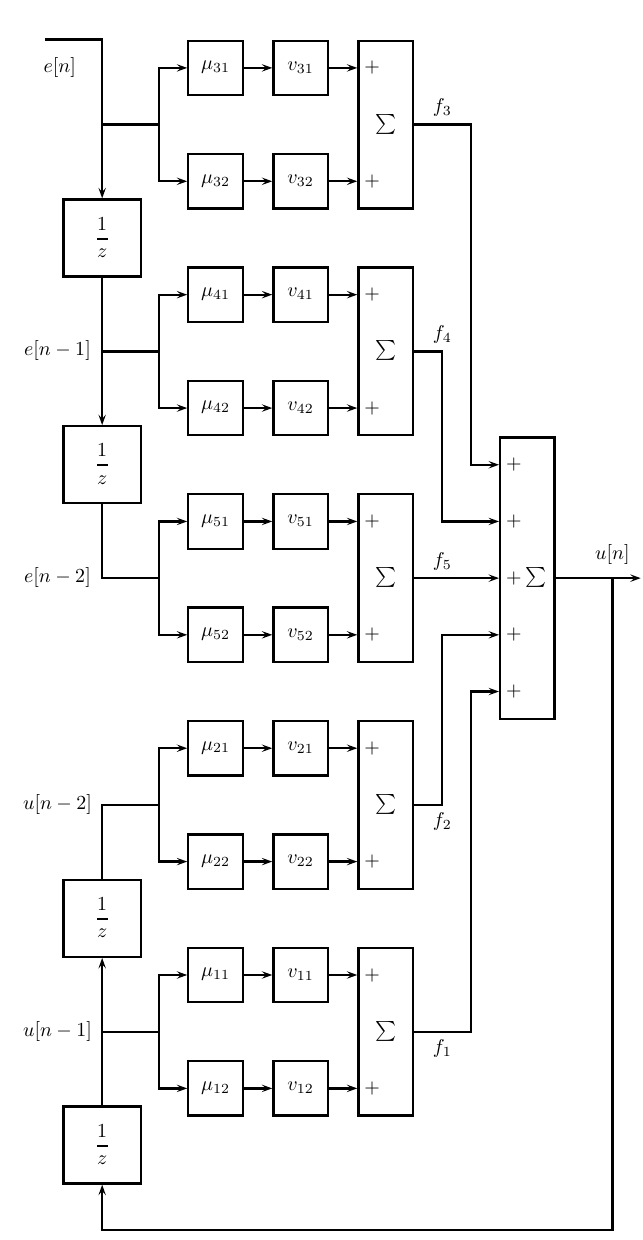
Figure 6. Fuzzy control system